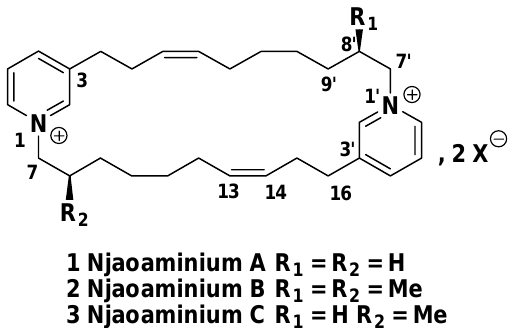
Figure 1. Structure of njaoaminiums A, B, and C